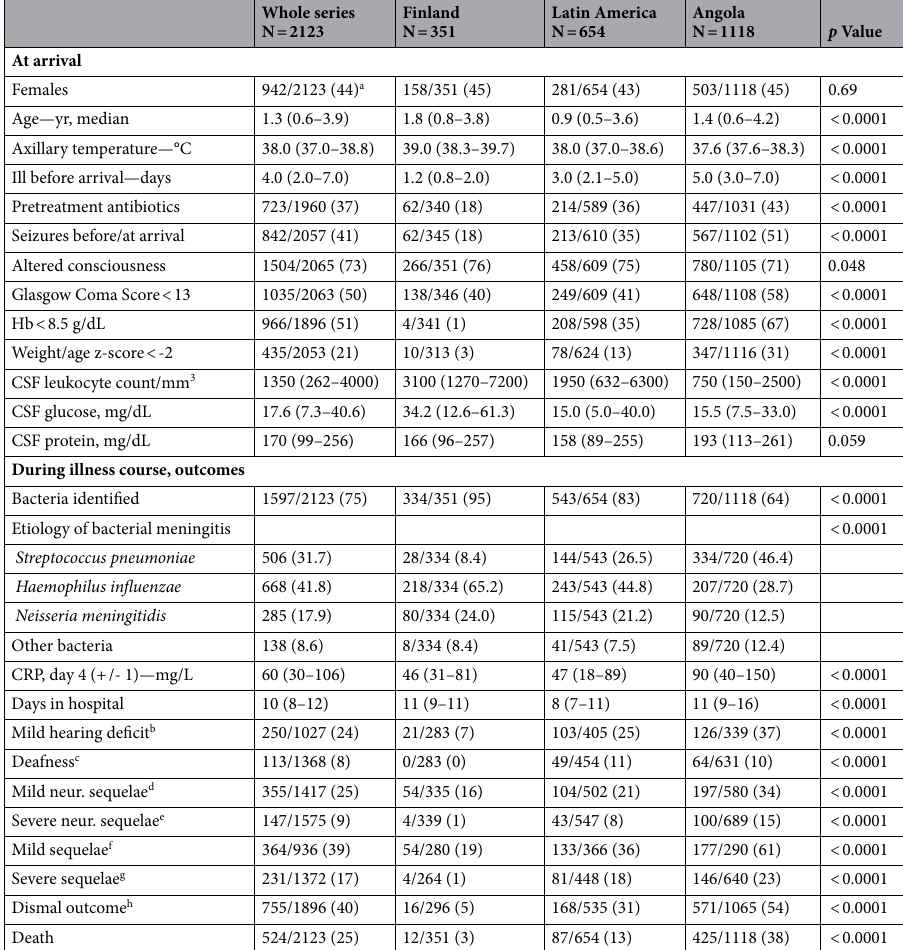
Table 1. Patient characteristics at arrival and during illness, and outcomes. a Data is presented in n/N (%) or median (interquartile range, 25–75 percentile), whichever relevant. b Better ear’s hearing threshold 41–79 dB. c Better ear’s hearing threshold ≥ 80 dB. d Other than severe neurological sequelae. e Blindness, quadriplegia/ paresis, hydrocephalus requiring a shunt, or severe psychomotor retardation. f Other than severe sequelae. g Deafness or severe neurological sequelae. h Death or severe neurological sequelae or